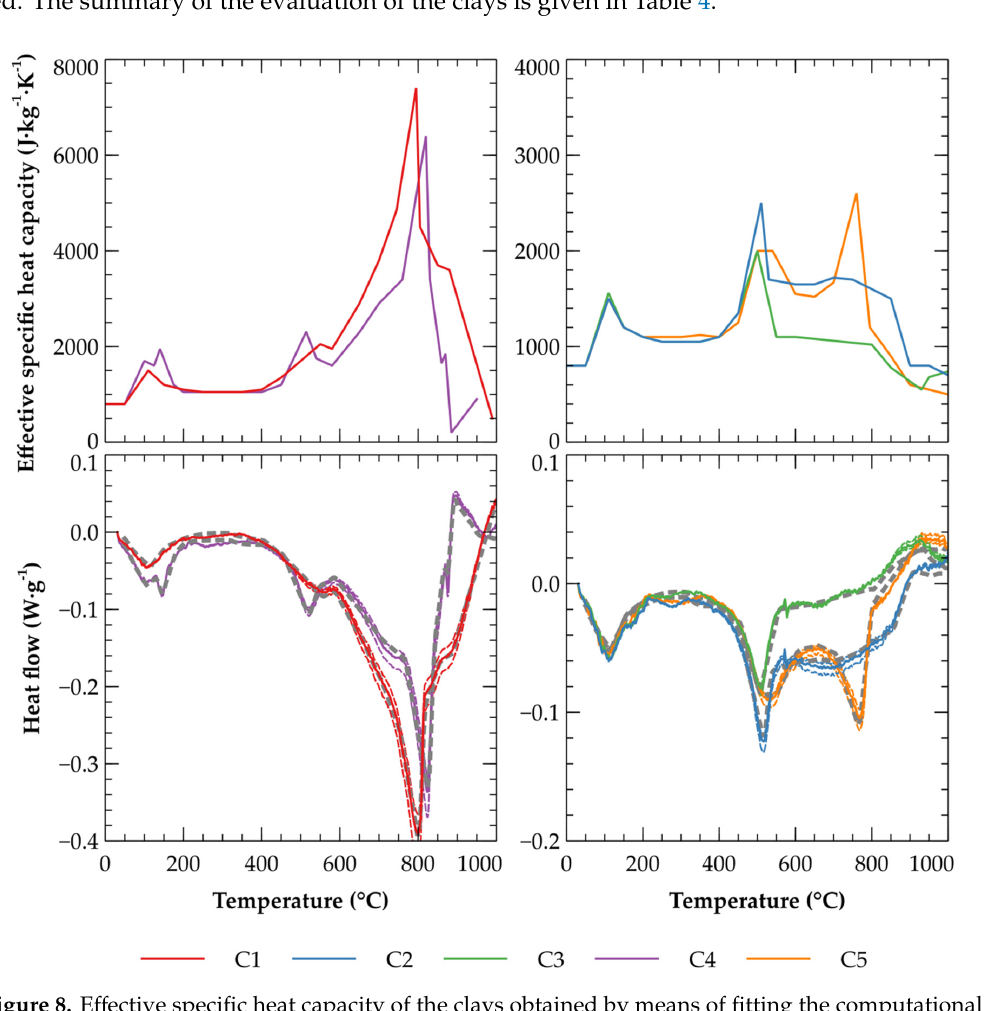
Figure 8. E ff ective specific heat capacity of the clays obtained by means of fitting the computational outputs on experimental data: ( Top ) the identified values of e ff ective specific heat capacity; ( Bottom ) a comparison of experimentally and computationally (gray dashed lines) obtained heat flows. The experimental uncertainties for particular heat flow curves are expressed using dashed lines of the corresponding color.